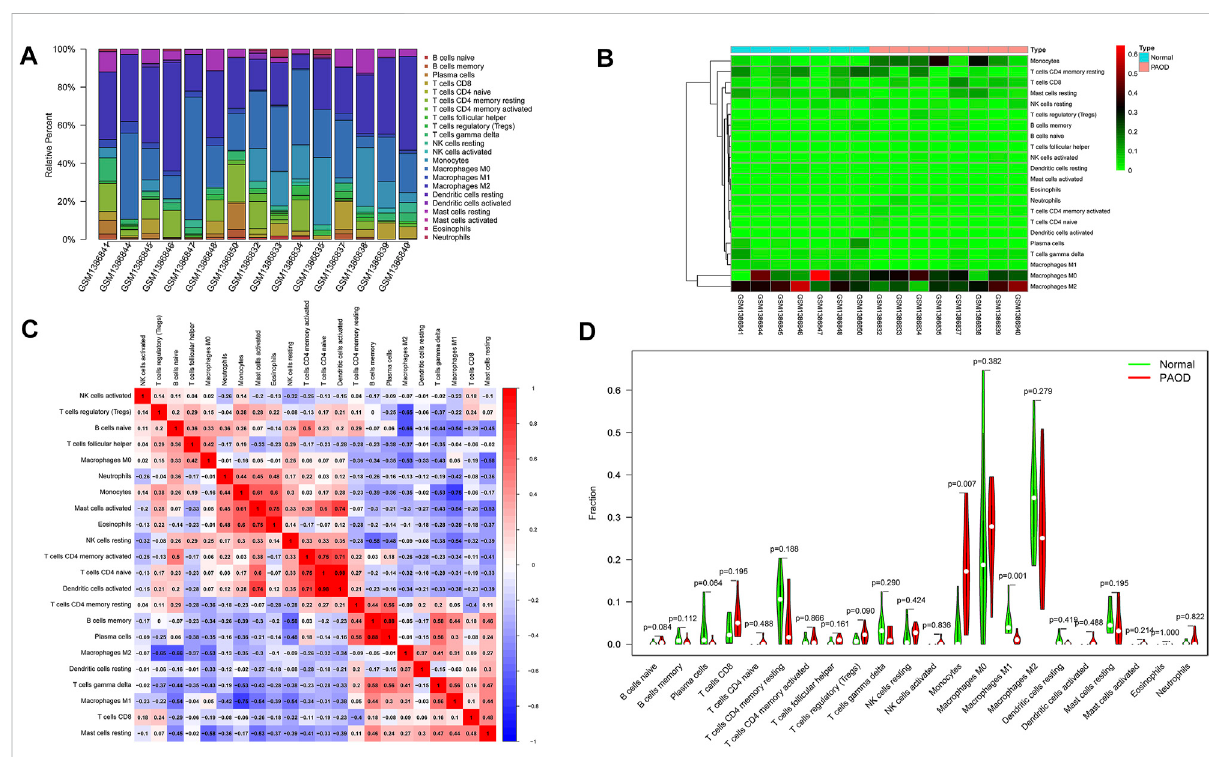
FIGURE 7 Compositionofin fi ltratingimmunecellsassessedusingtheCIBERSORTalgorithminPAODtissues. (A) Distributionofimmunecellin fi ltrationin each sample. (B) Heatmap of immune cell types. (C) Correlation among in fi ltrating immune cells. (D) Violin plot of in fi ltrating immune